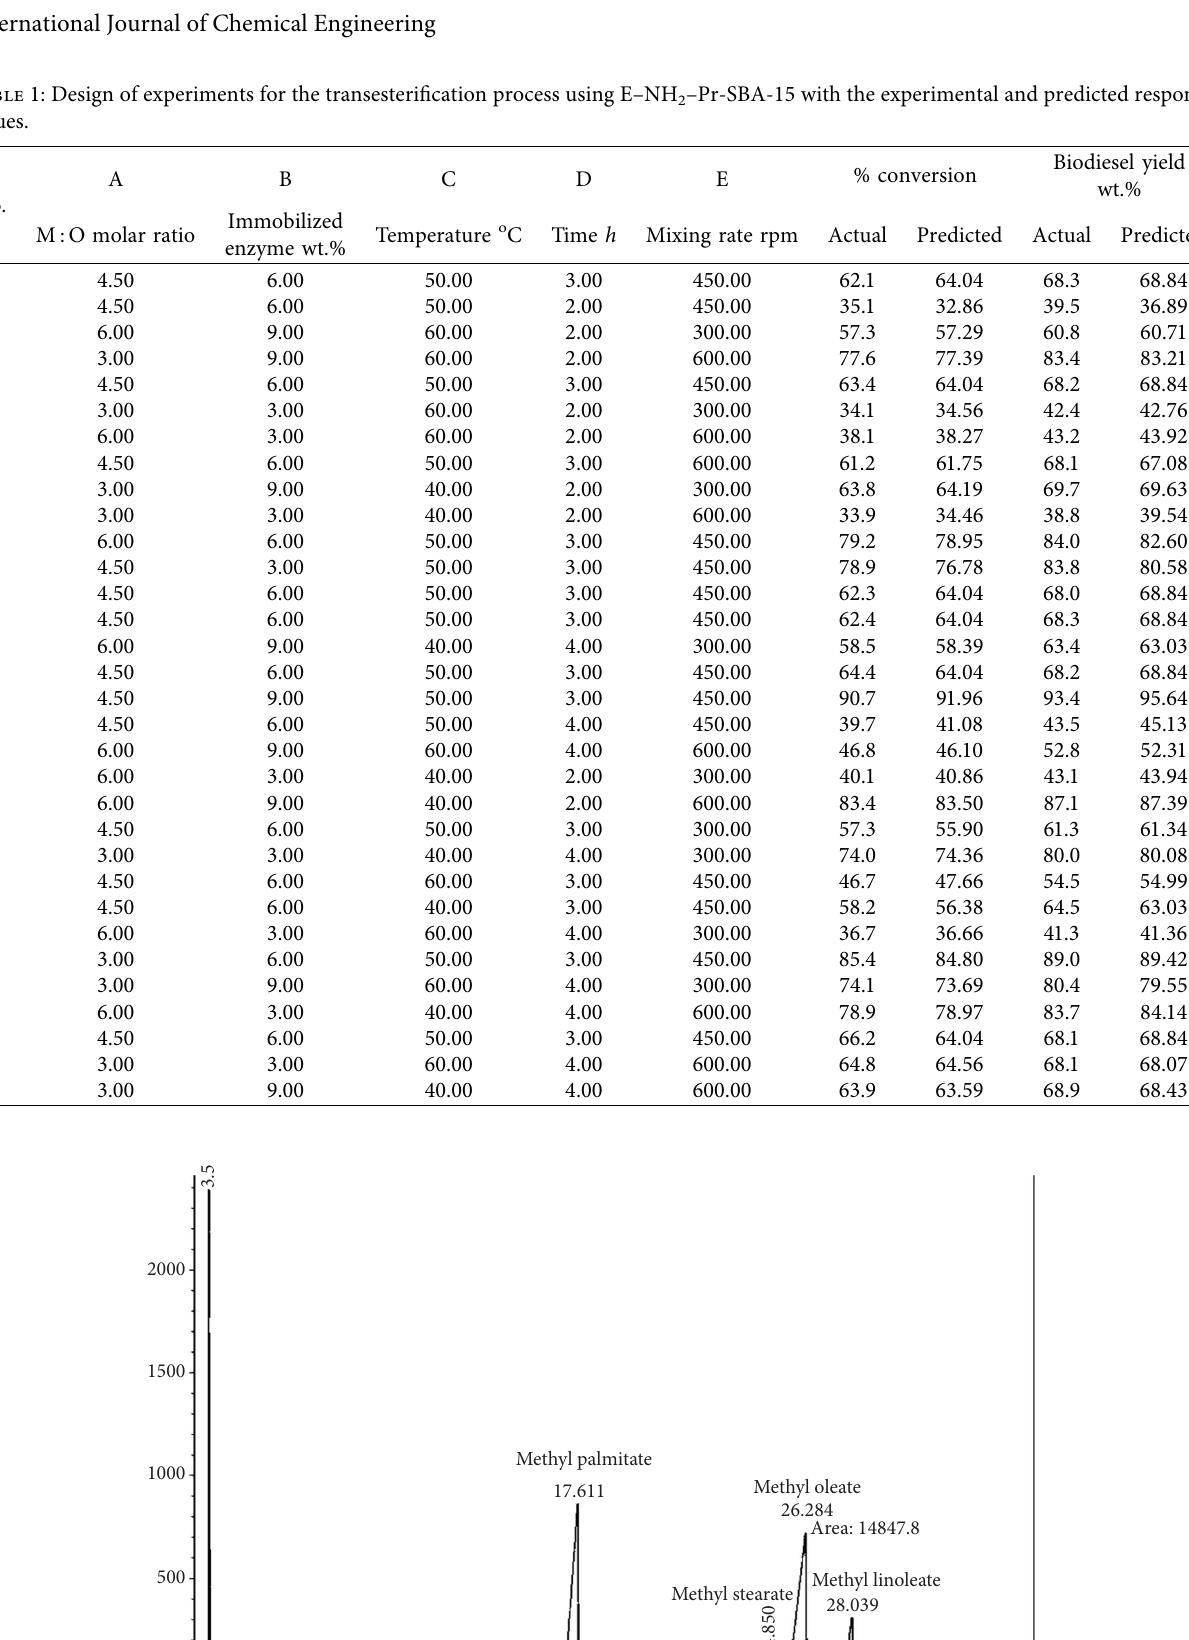
2 –Pr-SBA-15 with the experimental and predicted response